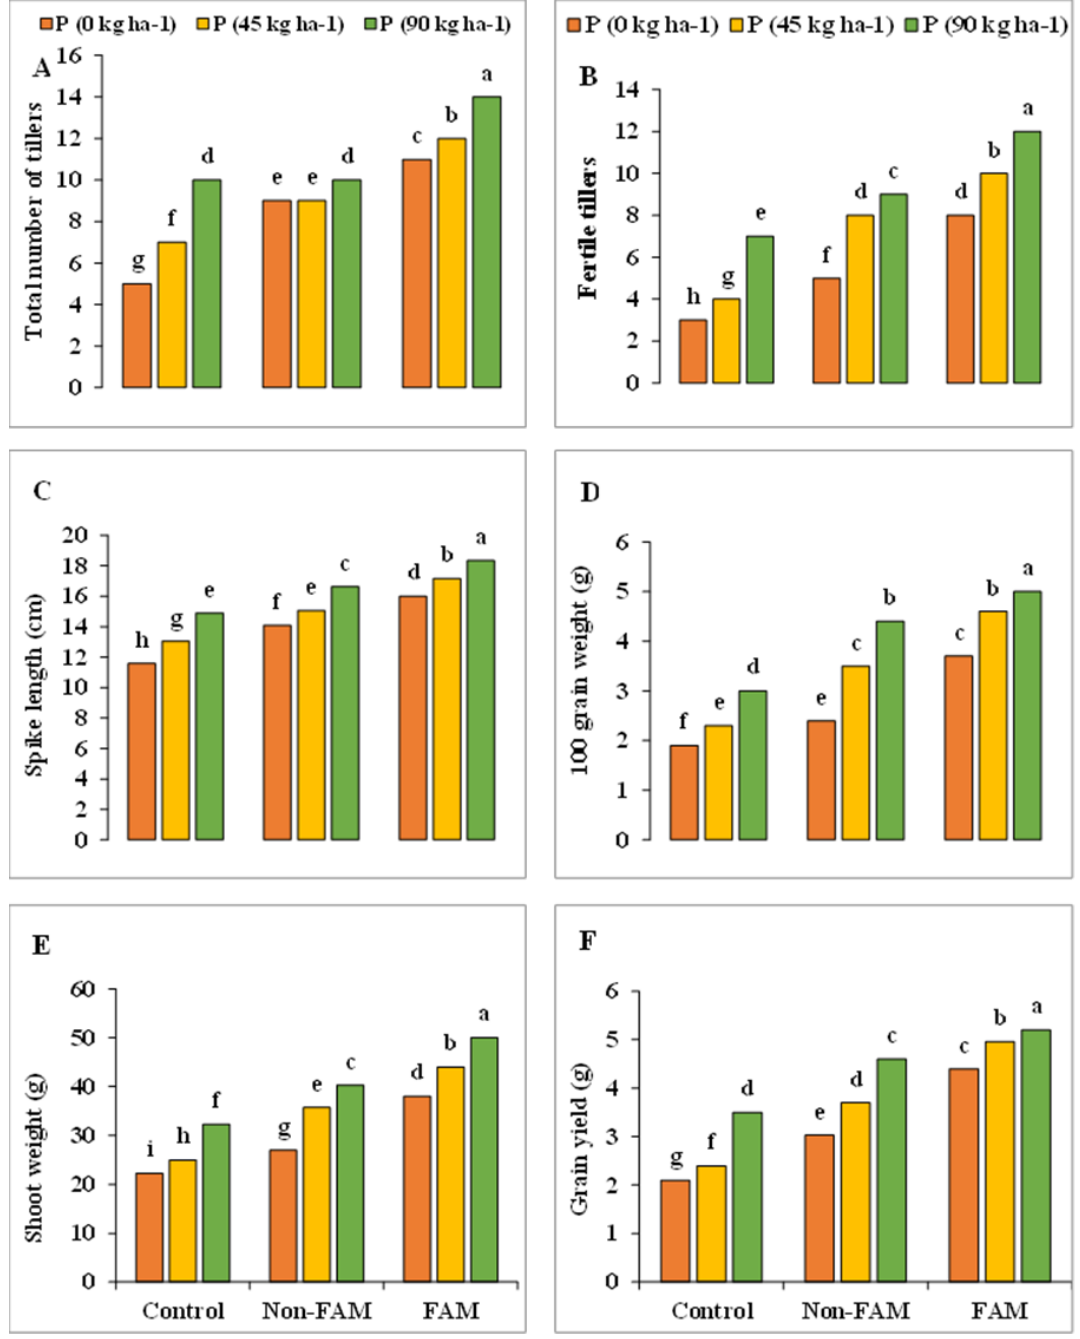
Figure 2. Combined use of fermented/non-fermented animal manure and phosphorus fertilizer on growth and yield parameters of wheat. ( A , B ) Total and fertile tillers, ( C ) spike length, ( D ) 100-grain weight ( E ) shoot weight, and ( F ) grain yield. Columns with different letters are significantly different from one another at a level of significance of p < 5%.